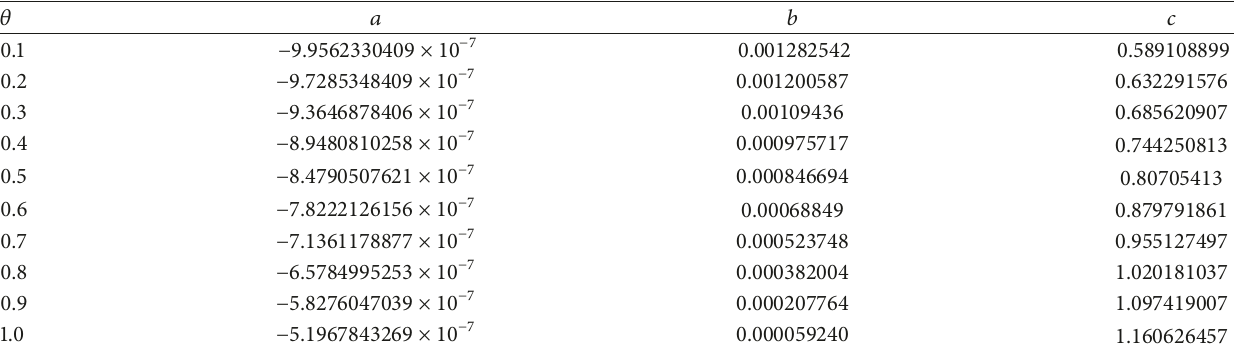
Table 5: The parameters 𝑎 , 𝑏 , and 𝑐 of the quadratic function by varying safety loading 𝜃